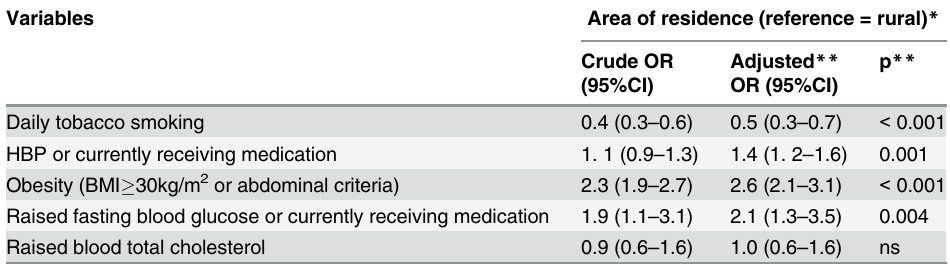
Table 5. Association (adjusted for age group and gender) between cardiovascular risk factors and area of residence: multivariables logistics regressions (data from Steps Benin 2008 sample).